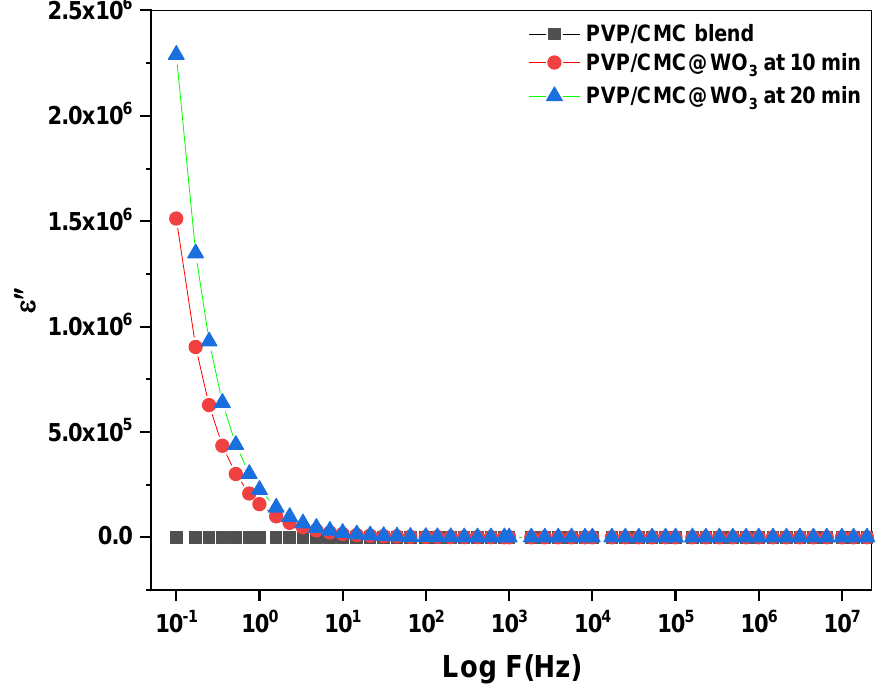
Figure 7. The imaginary part (ε”) versus log f for PVP/CMC and PVP/CMC-WO 3 at two laser-ablation times (10 and 20 min).